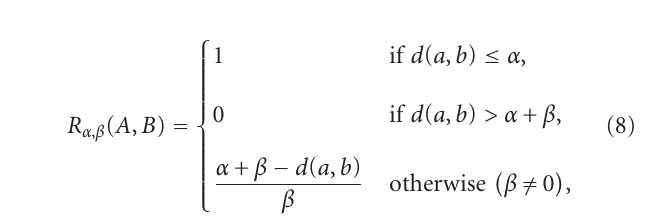
Top. rel. = NTPPI Dir. = All